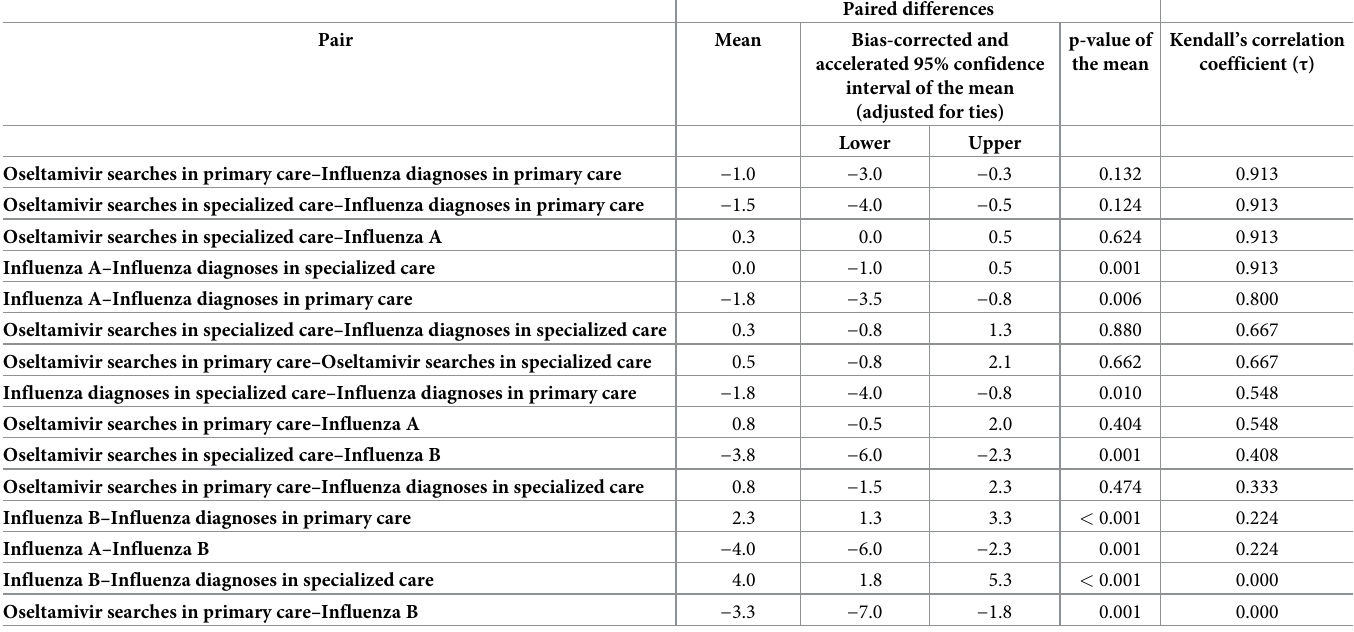
Table 3. Pairs, paired differences with the mean, bias-corrected and accelerated confidence intervals and p-values, and correlations. Primary care searches for oselta- mivir oral suspension, specialized care searches for oseltamivir oral suspension, children’s influenza diagnoses in primary and specialized care, and laboratory reports of children’s influenza A and B were paired and calculated and bootstrapped according to epidemic starting